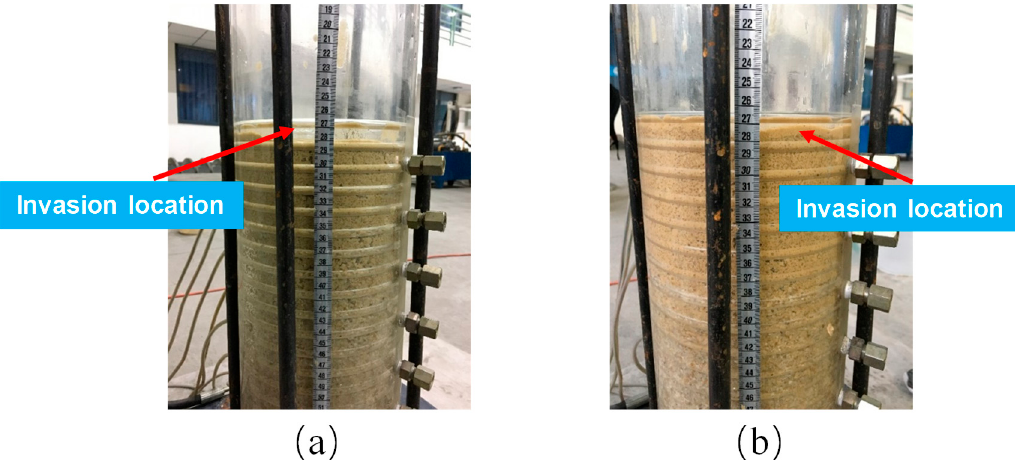
Figure 7. Mud invasion state in G3 stratum. ( a ) 1# Mud intrusion formation; ( b ) 3# Mud intrusion formation .